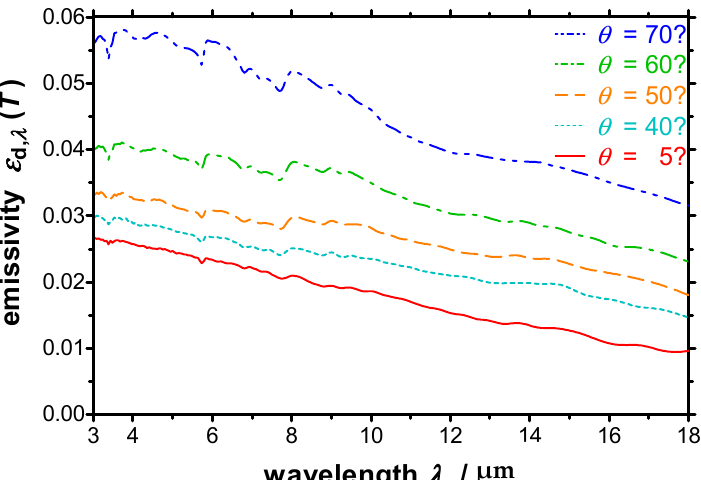
Figure 16. Spectral directional emissivity of polished copper measured with the EMMA at a temperature of T = 973 K and different emission angles. The emissivity increases with increasing emission angle as expected for an electrically conducting material.